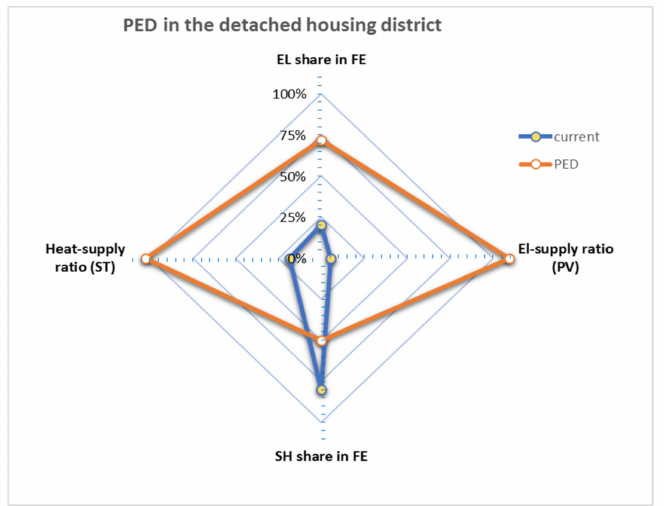
Figure 5. Key development indicators of transforming the detached housing district to PED (source: AIT). EL—electricity; SH—space heating; ST—solar